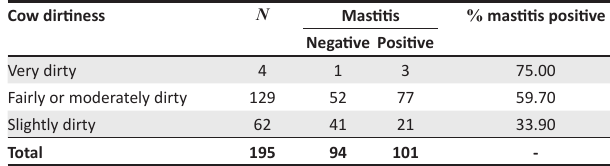
TABLE 1: Mastitis prevalence across milk collection centres.